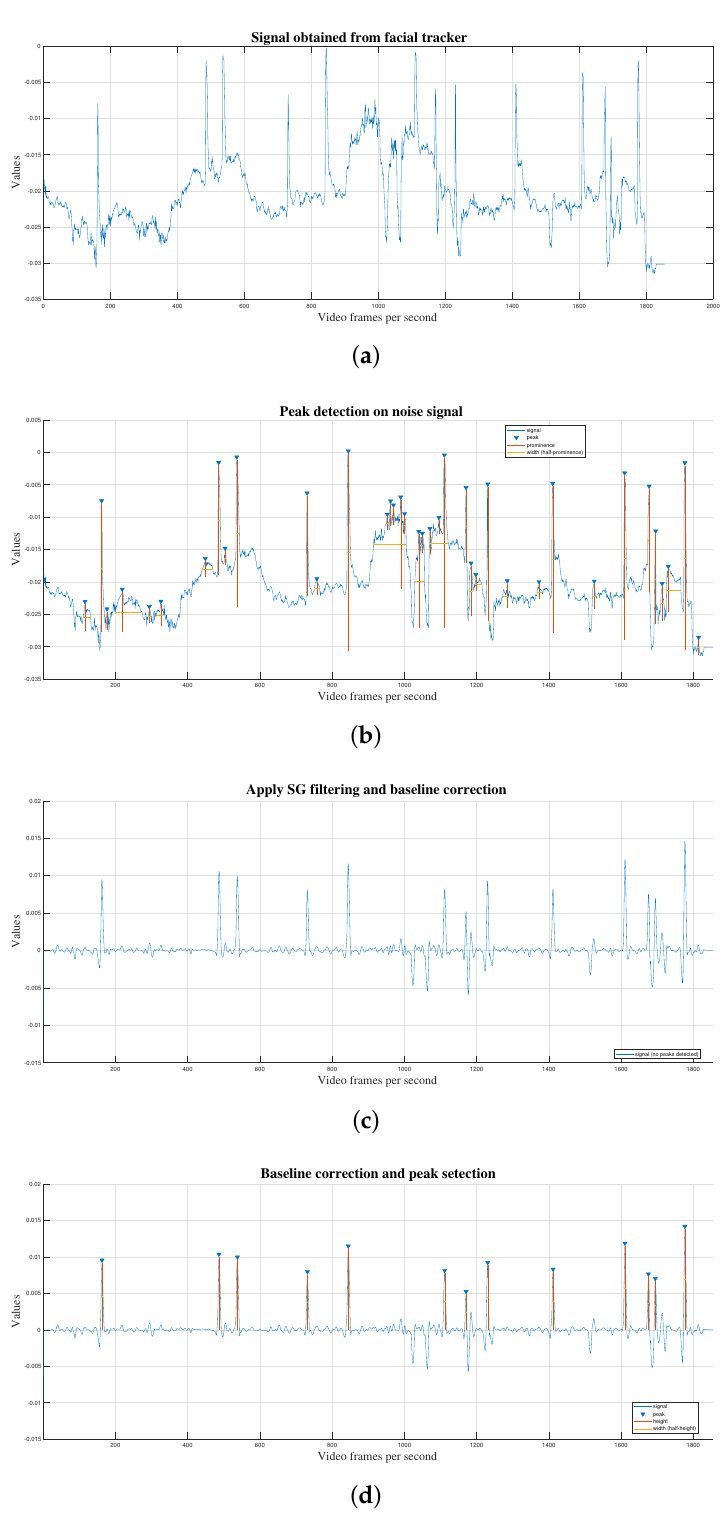
Figure 3. Processing steps leading to the detection of eye blinks: ( a ) Signal obtained from facial landmark tracker in a video racking session, ( b ) peak detection applied to the noisy signal, ( c ) SG filter applied to the signal and baseline corrected , and ( d ) peak detection mrthod is applied on the filtered